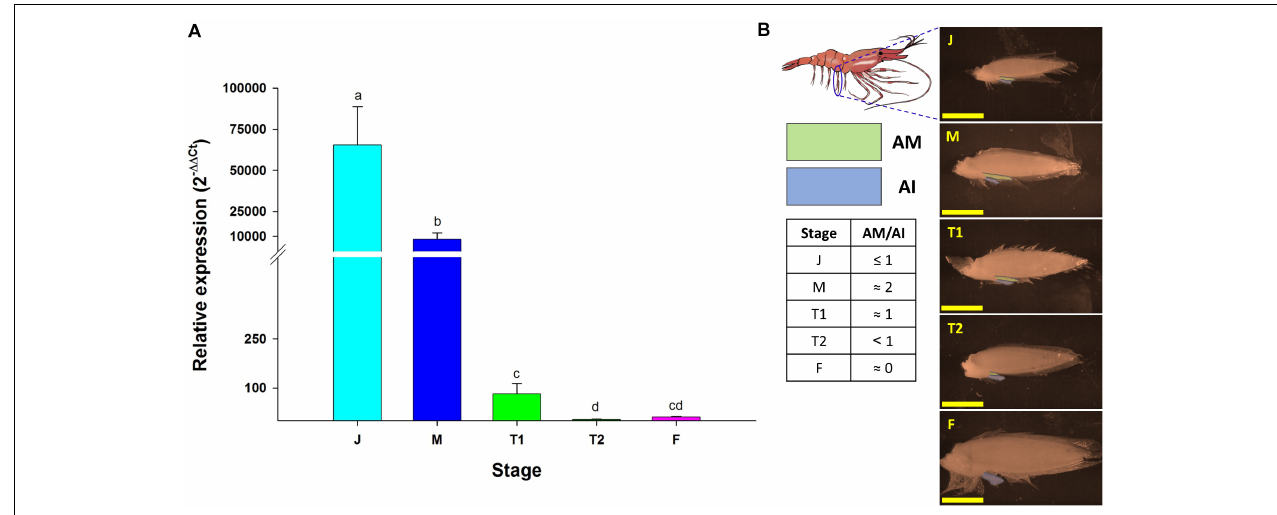
FIGURE 2 | Pnp-IAG expression in different reproductive stages of P. platyceros . (A) Relative expression of Pnp-IAG from androgenic glands of the different reproductive stages: (J) Juvenile ( n = 10), (M) Male ( n = 8), (T1) Early transitional ( n = 7), (T2) Late transitional ( n = 6), (F) Female ( n = 8). Error bars represent standard error of the means and statistical difference between the stages is distinguished with letters. (B) Second pleopods at different reproductive stages. The location of the second pleopod is shown in the blue circle (top left). Appendix masculina ( AM ; green) and appendix interna ( AI ; blue) are highlighted. Bar scales (= 5 mm) are consistent in all photos. The AM/AI ratio in the different reproductive stages are given in the table.